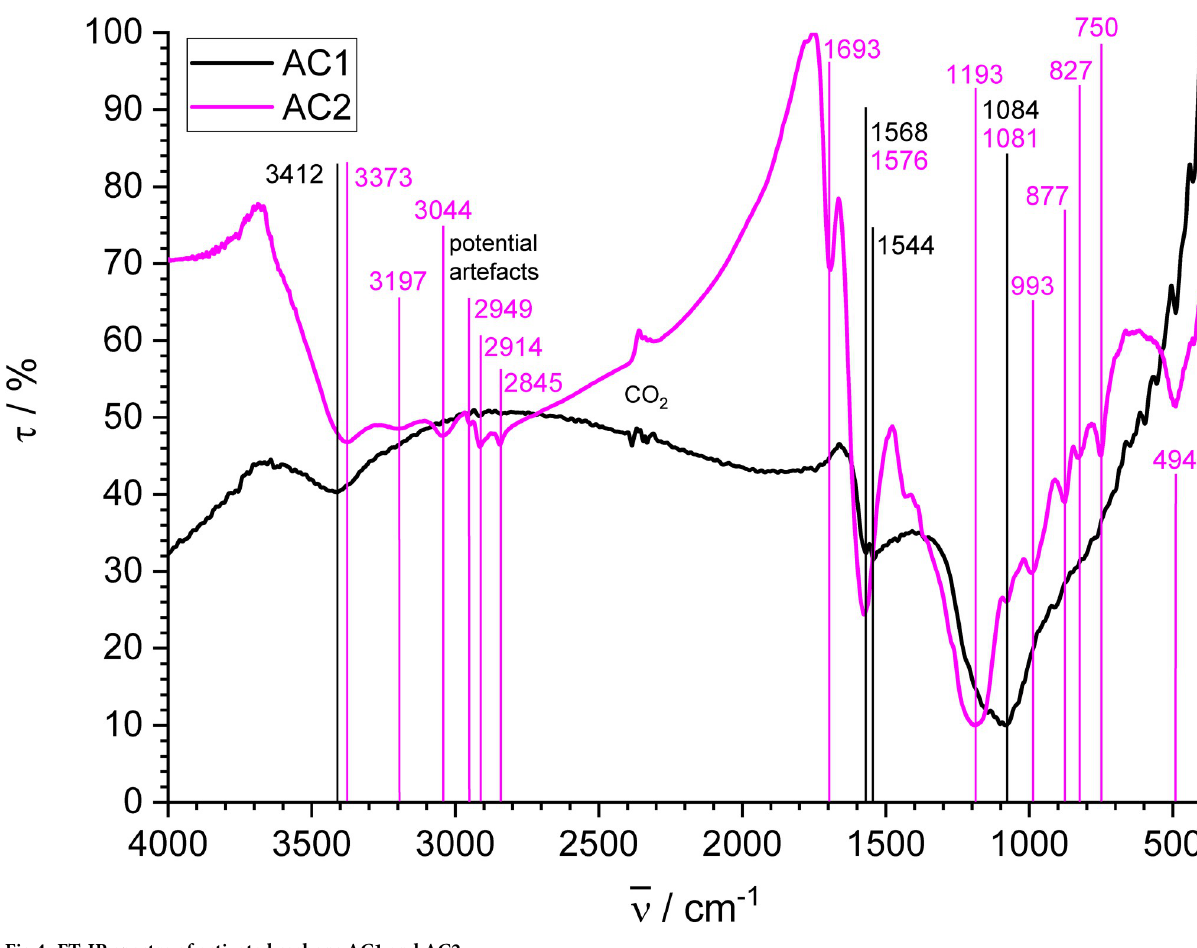
Fig 4. FT-IR spectra of activated carbons AC1 and